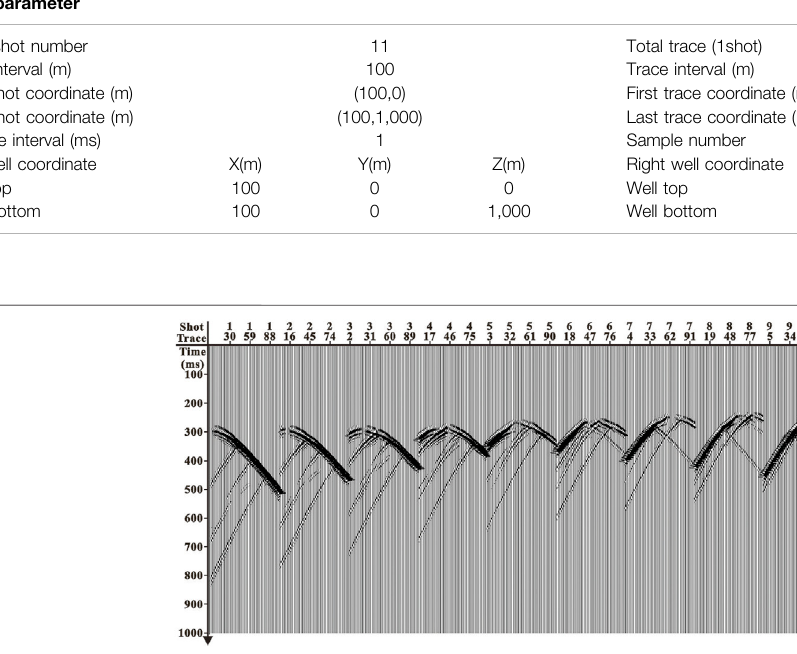
FIGURE 5 | Original fi eld seismic data.